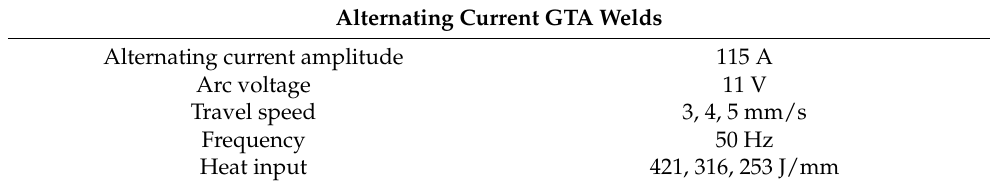
Table 2. GTA welding